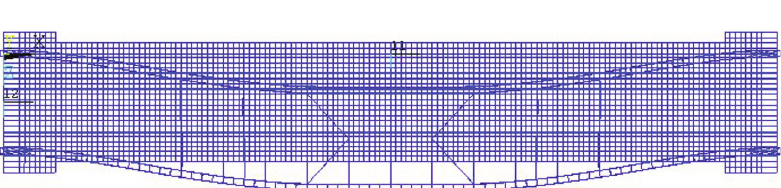
Figure 22: The fi rst order buckling mode of arch bridge under case 7.